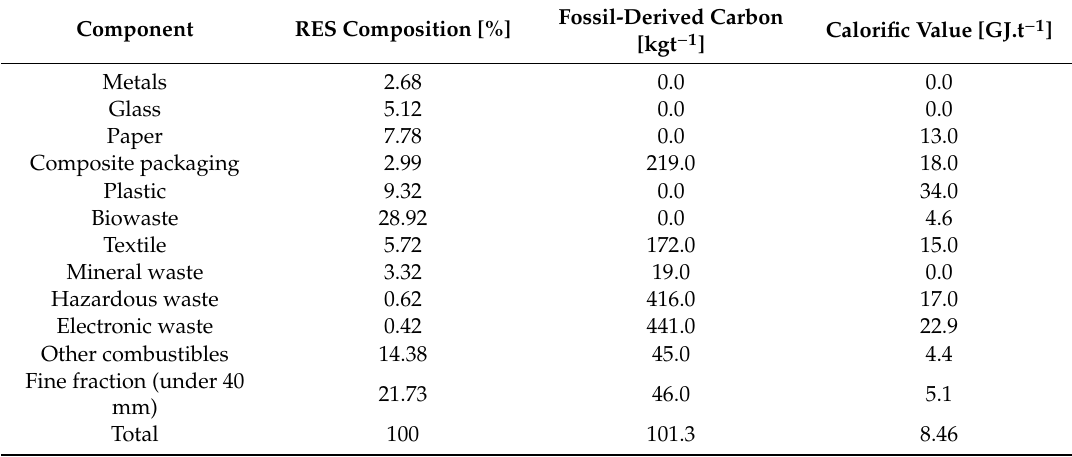
Table A1. RES composition for the Czech Republic obtained using tool JUSTINE [28] for 2016.